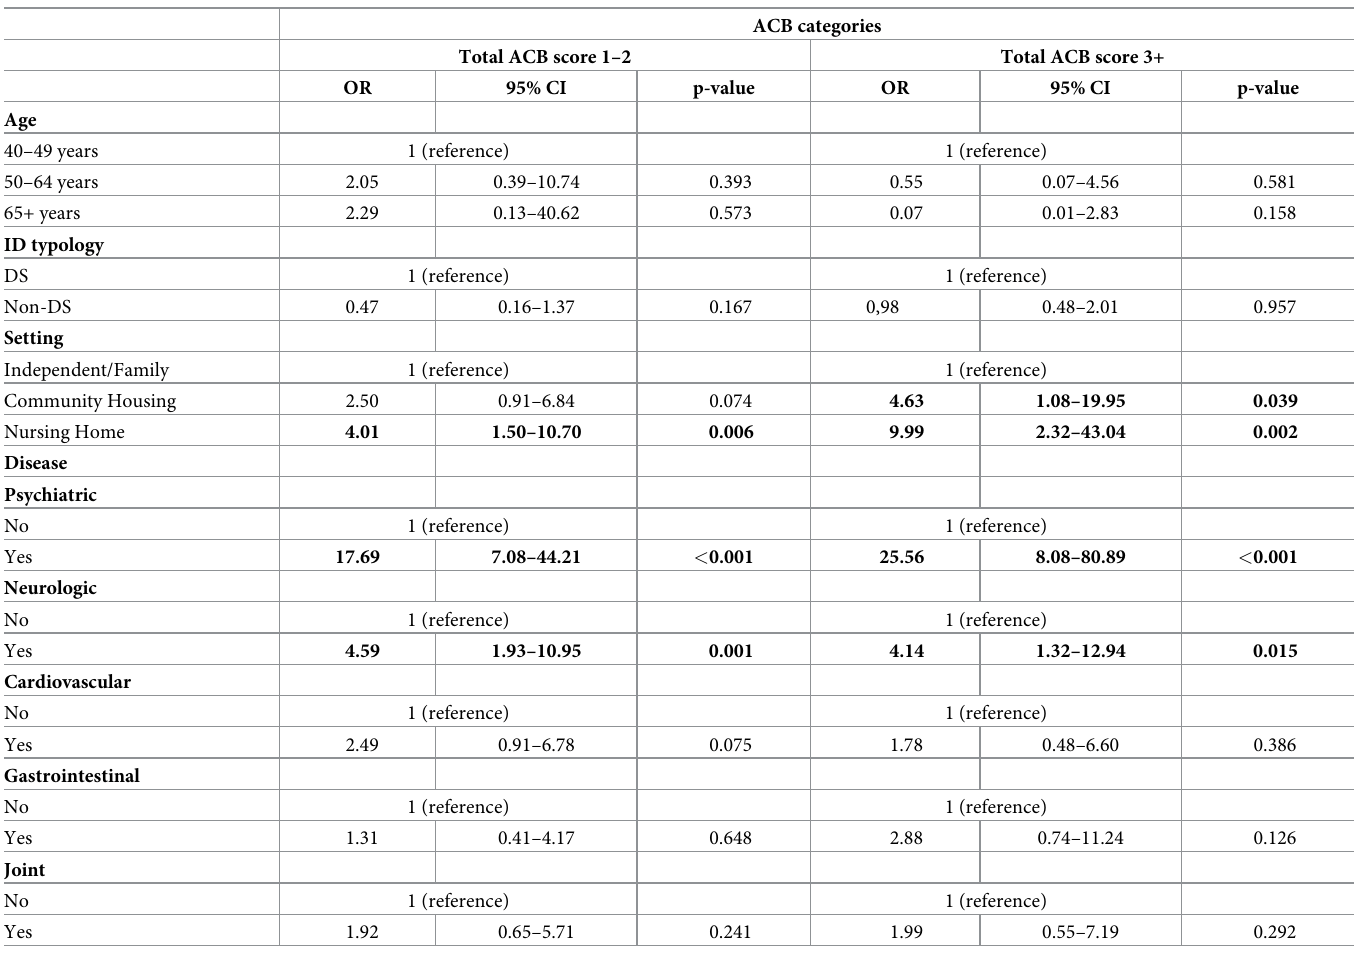
Table 3. Multivariate analysis of significant factors associated with total ACB score 1–2 and ACB score 3+ (n =